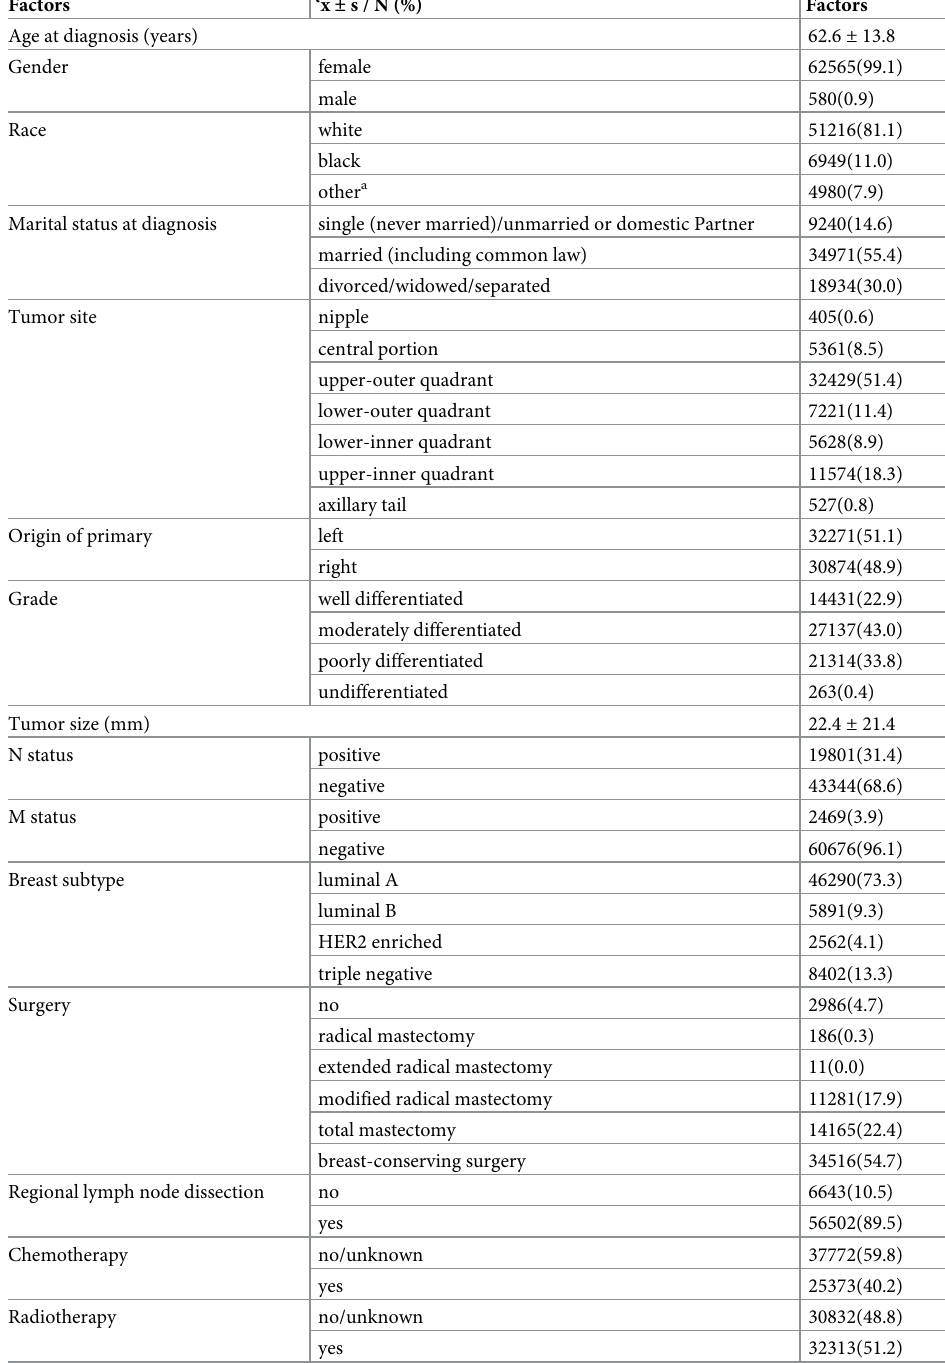
Table 1. Descriptive characteristics of 63145 BC